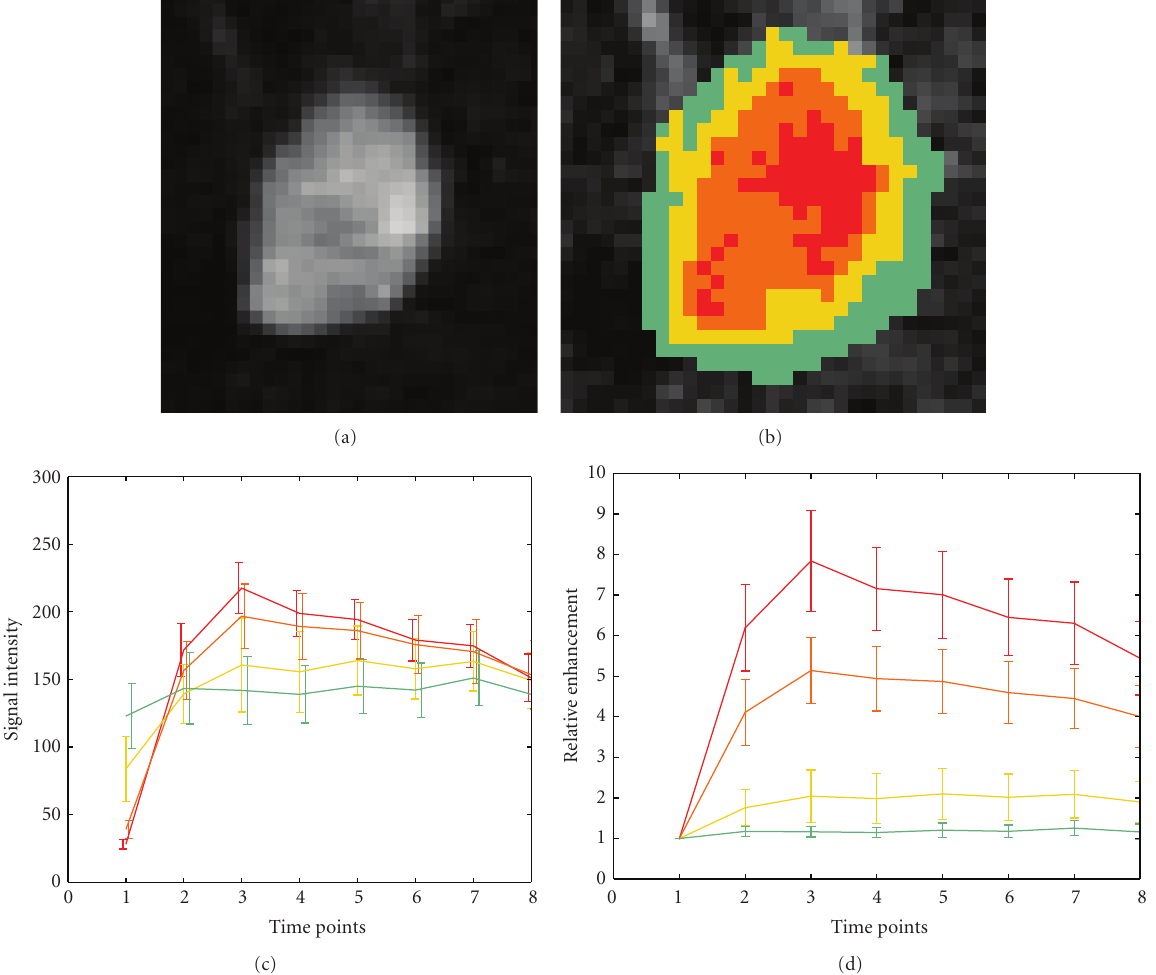
Figure 3: DCE-MRI image (a) and overlaid lesion clustering (b), comparison between the average raw (c), and normalized curves (d) calculated for each